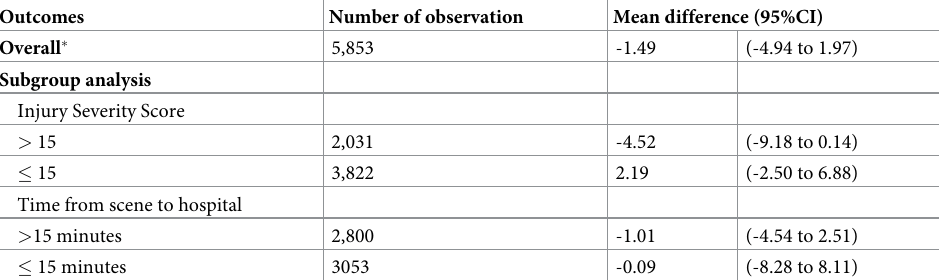
Table 2. Mean difference in length of hospital stay between those receiving helicopter or ground emergency medi- cal services.